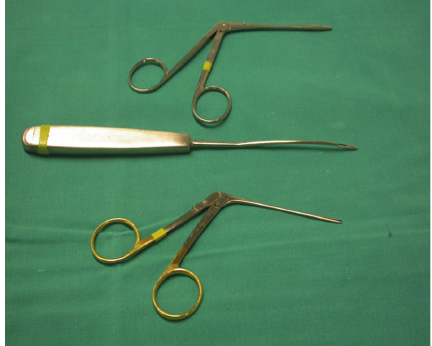
Figure 2: Technique for the insertion of the graft at the intern of the mucous membrane of the